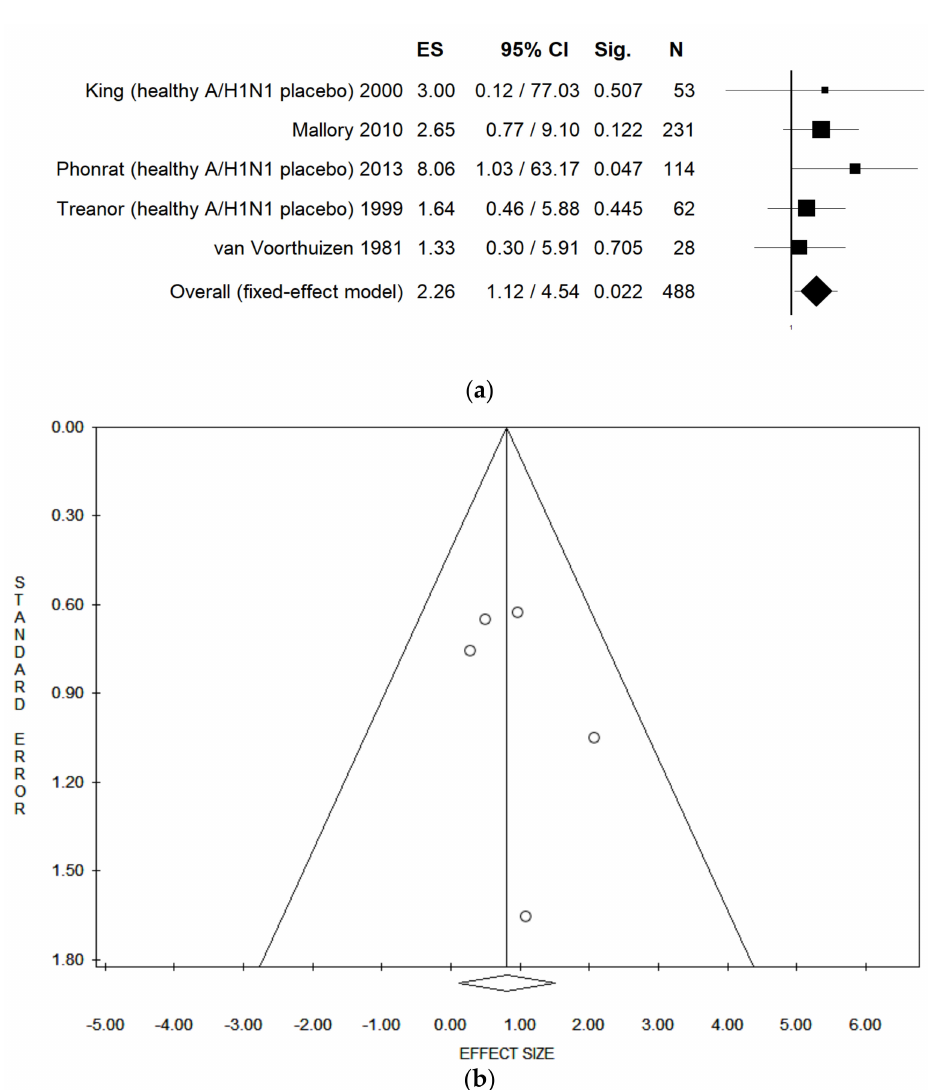
Figure 3. ( a ) Forest plot and ( b ) funnel plot of the meta-analysis comparing seroconversion of LAIV compared placebo of healthy adults for A/H1N1. ES: effect size reported as odds ratio. Sig: p -value. References: King 2000 [38],